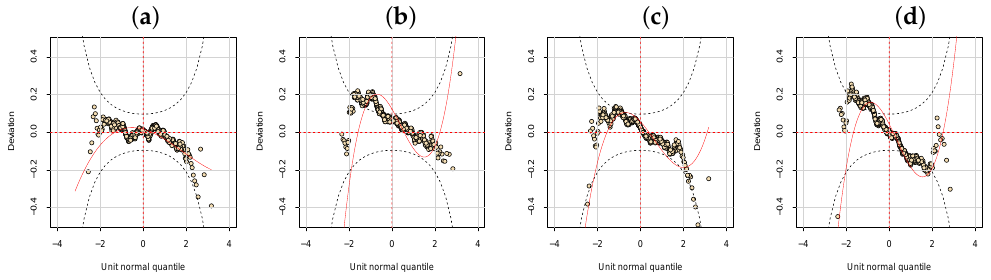
Figure 9. Worm plots of the qrs for COVID-19 data in Campinas from the regression models: ( a ) WBP; ( b ) BBP; ( c ) KwBP; ( d ) BP.